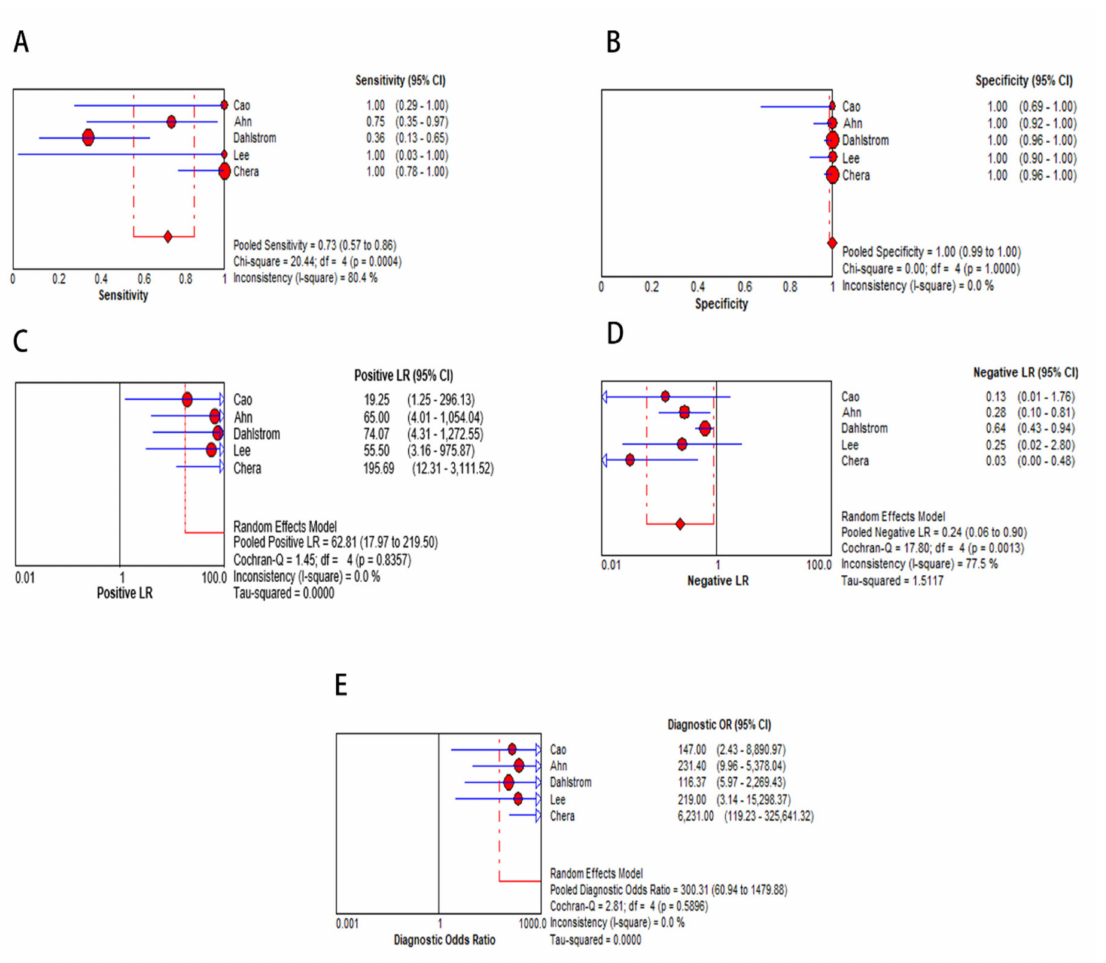
Figure 6. Diagnostic accuracy displayed by forest plots estimating ( A ) sensitivity, ( B ) specificity, ( C ) PLR, ( D ) NLR, and ( E ) DOR for analysis of cfHPV-DNA in detecting recurrence (confidence interval (CI) in brackets). Size of red dots represents sample size included in